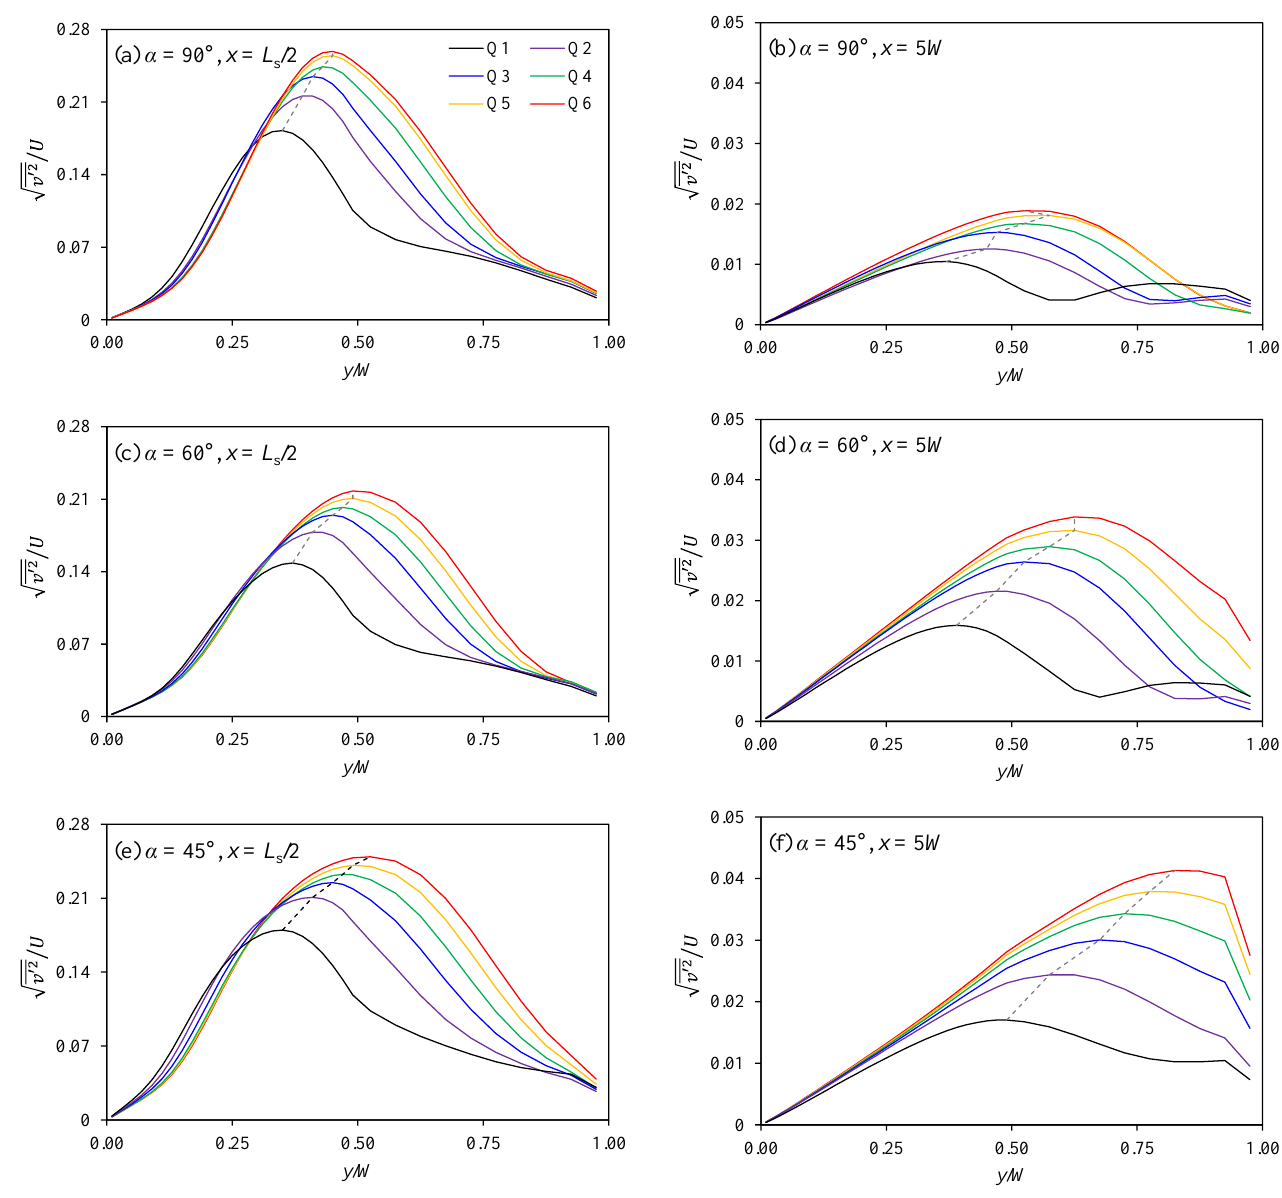
Figure 7. The relative intensity of transverse velocity shear against the primary velocity at x = L s /2